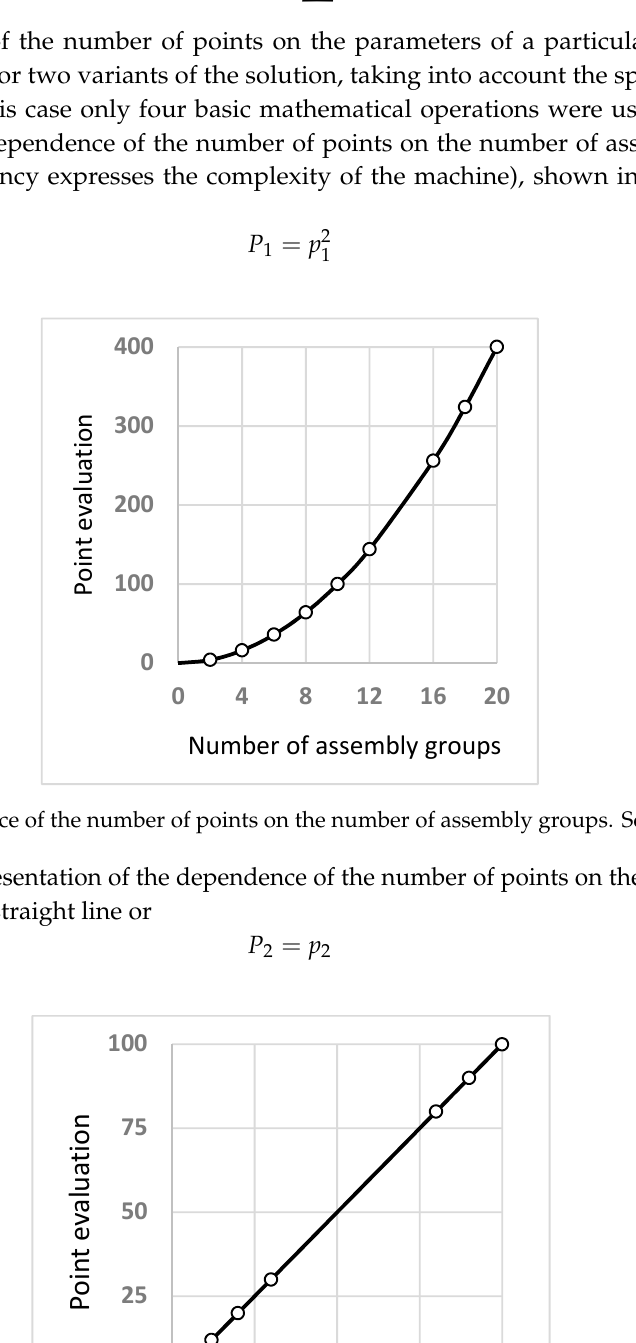
Figure 4. Dependence of the number of points on the degree of machine accuracy. Source: authors.